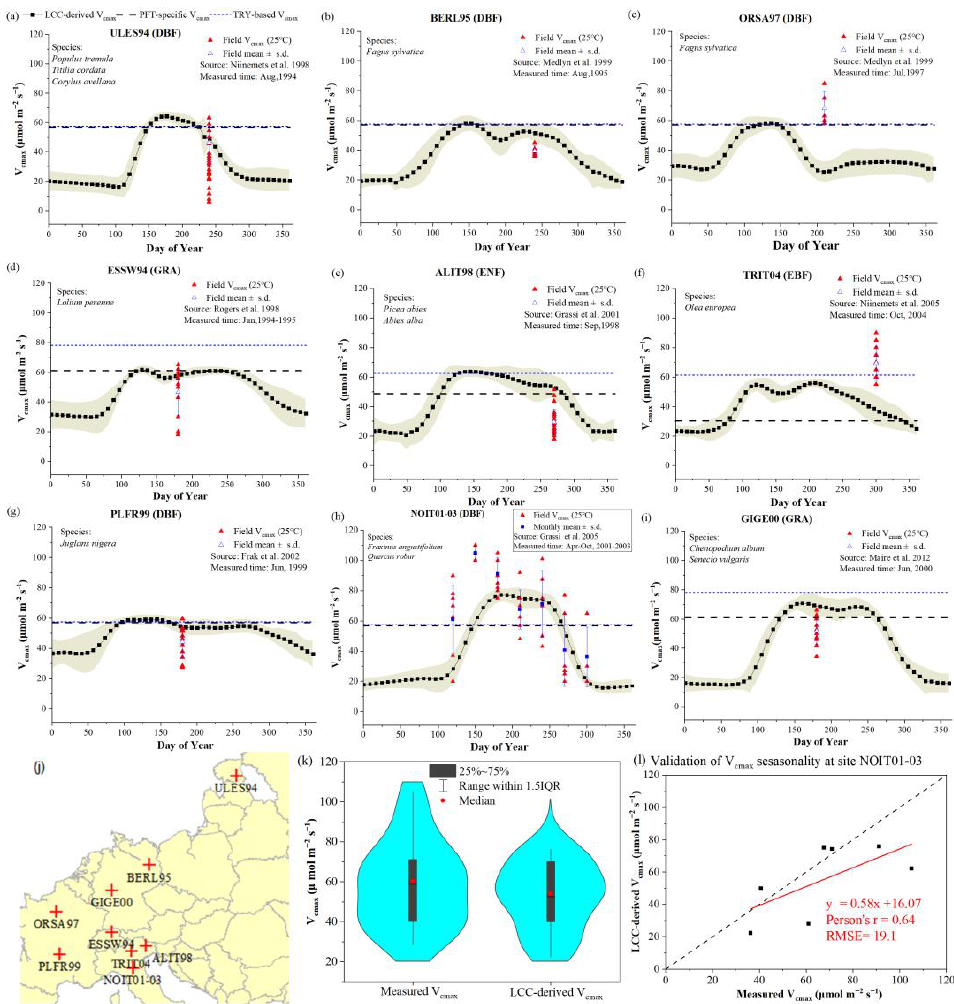
Figure 12. Comparison of V cmax derived from the LCC, PFT-specific V cmax , and field-measurements for the following sites: ( a ) ULES94, ( b ) BERL95, ( c ) ORSA97, ( d ) ESSW94, ( e ) ALIT98, ( f ) TRIT04, ( g ) PLFR99, ( h ) NOIT01-03, and ( i ) GIGE00. The geographical map in ( j ) shows the locations of these nine sites in Europe. The violin plot in ( k ) compares the monthly mean values of V cmax measurements and corresponding V cmax derived from LCC-derived V cmax maps. The scatter plot in ( l ) validates the LCC-derived V cmax using time series field measurements collected at site NOIT01-03 during the growing season (April to October). The abbreviations in ( a – i ) denote the PFTs of each site according to field surveys of plant species. Four PFTs are included, including deciduous broadleaf forest (DBF), evergreen broadleaf forest (EBF), evergreen needleleaf forest (ENF), and grasslands